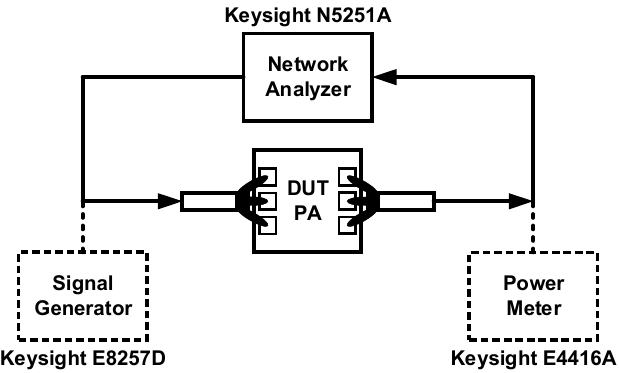
Figure 6. The measurement setup for S -parameters and output power. The measured S -parameters are shown in Figure 7. The PA achieves a peak small signal gain of 16.8 dB at 70 GHz and a 3 dB bandwidth of about 9 GHz. The S 11 is below − 10 dB from about 68 to 72 GHz, and S − 13 dB from 71 to 86 GHz. The 22 is below measured stability factor K is larger than unity, as shown in Figure 8, indicating that the PA is unconditionally stable. Figure 9 shows the simulated S 21 at 81 GHz due to the neutralization capacitor variations from the Monte Carlo simulation. The measured gain, output power, and PAE at 81 GHz are shown in Figure 10. The PA achieved 11.2 dBm P 1dB and 12.7 dBm P sat with a P 1dB / P sat ratio of 88% in dBm compared to 75% in [2]. The PA exhibited a PAE 1dB of 15.6% and a PAE max of 17.5%. The measured PAE at 6 dB PBO is 6.5%. Figure 11 plots the large-signal performance over 75–85 GHz; the measured P 1dB ranges from 9.2 to 11.2 dBm and P sat ranges from 11.3 to 12.7